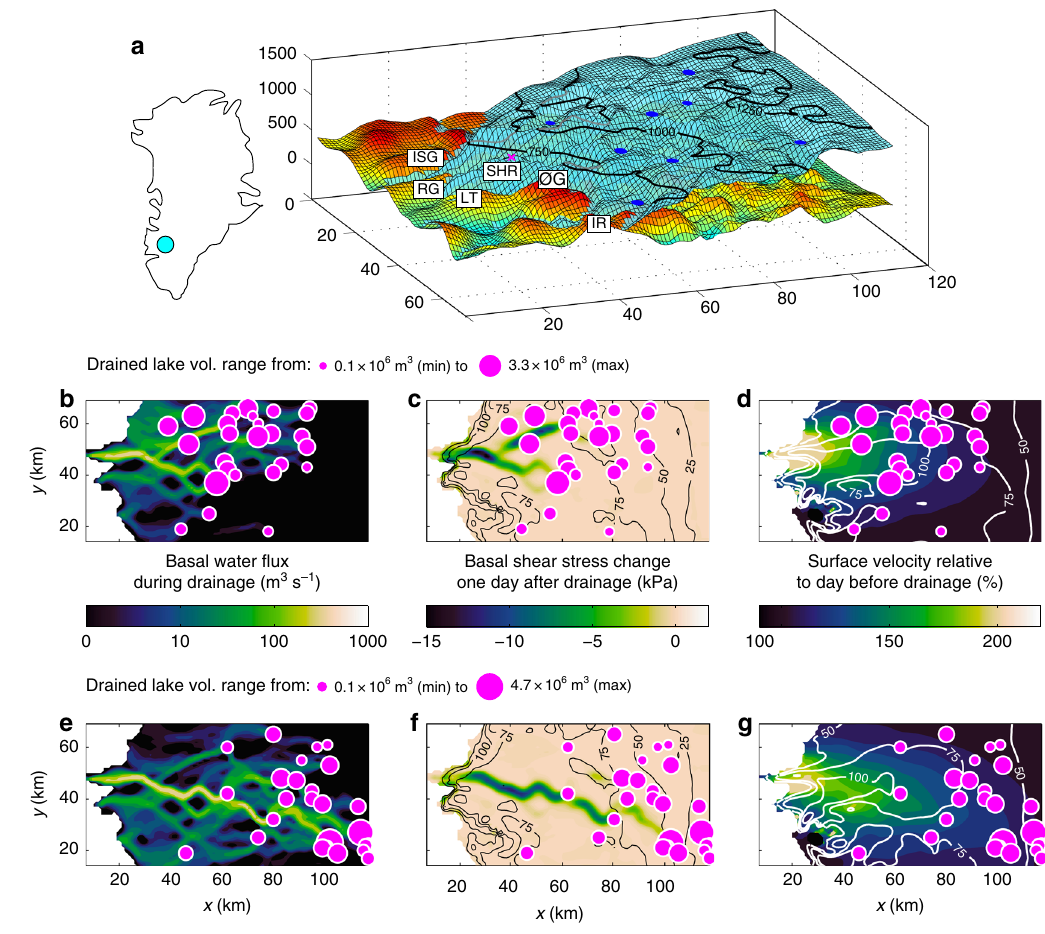
Fig. 1 Cascading supraglacial lake drainage events. a Numerical model of the Kangerlussuaq sector of the Greenland Ice Sheet, including Isunnguata Sermia (ISG), Russell Glacier (RG), Leverett Glacier (LT), Ørkendalen Glacier (ØG), Isorlersuup Glacier (IR) and site SHR on the K-transect. b Flux of water in the basal drainage network on 21 June when 26 lakes drained rapidly. Solid magenta dots denote location and volume of lakes, which lost between 0.1 and 3.3 million cubic metres of water when they drained. c Change in basal shear stress one day after drainage when the ice sheet has responded to the lubrication of fl ow by surface water injected at the bed. Black contours show absolute values of basal shear stress prior to drainage. d Surface velocity relative to day before drainage. White contours show absolute values of surface velocity prior to drainage. e – g same as b – d but for cascading lake drainage on 18